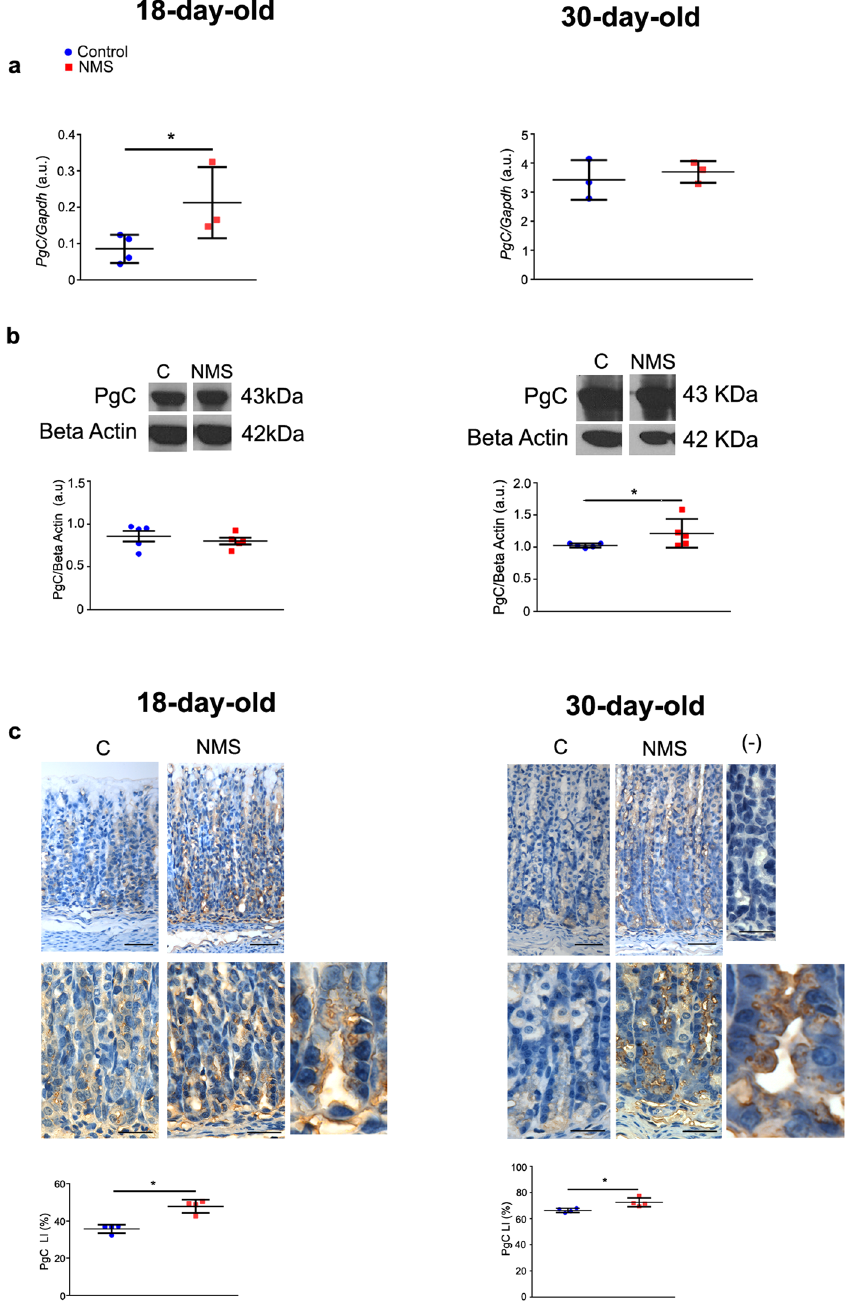
Figure 4. NMS effects on pepsinogen C at gene expression ( PgC ), protein levels and distribution of zymogenic cells in the gastric mucosa at 18 and 30 days. ( a ) Gene expression was evaluated by RT- qPCR and shown as fold change of Gapdh . ( b ) Detection of pepsinogen C and pepsin protein levels after immunoblot. Bands were cropped to represent control and NMS groups (whole blot in Supplementary Fig. 4). Densitometry was normalized to Beta-actin loading control. ( c ) Representative photomicrographs of the base region of gastric glands, showing PgC immunohistochemistry. Negative control is devoid of any reaction. Bars = 50 µ m; high magnification at 30 days: bars = 25 µ m. For both ages, the last panel shows X2 digital zoom to depict cellular details. Labeling index (LI) (%) was obtained as described for control (blue) and NMS (red) groups at 18 and 30 days. Values are individually represented as well as means ± SD. * P < 0.05 as compared to control group by Student t